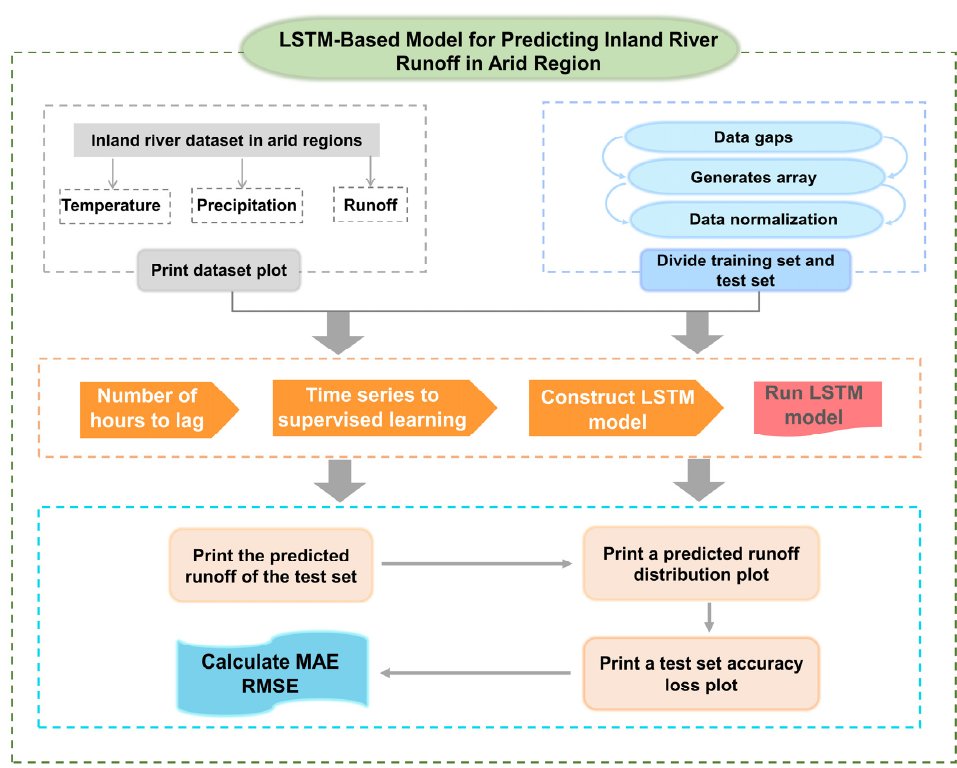
Figure 6. Runoff simulation and prediction system structure in LSTM model.